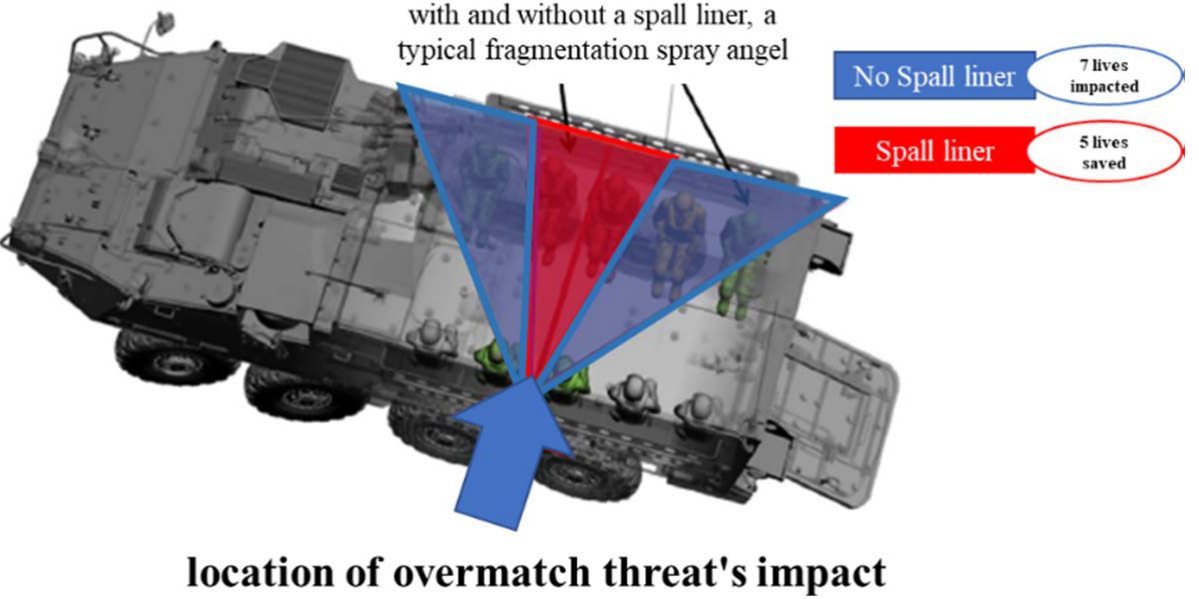
Figure 4. Spall liner saves lives in overmatch in hypothetical armor personnel carrier